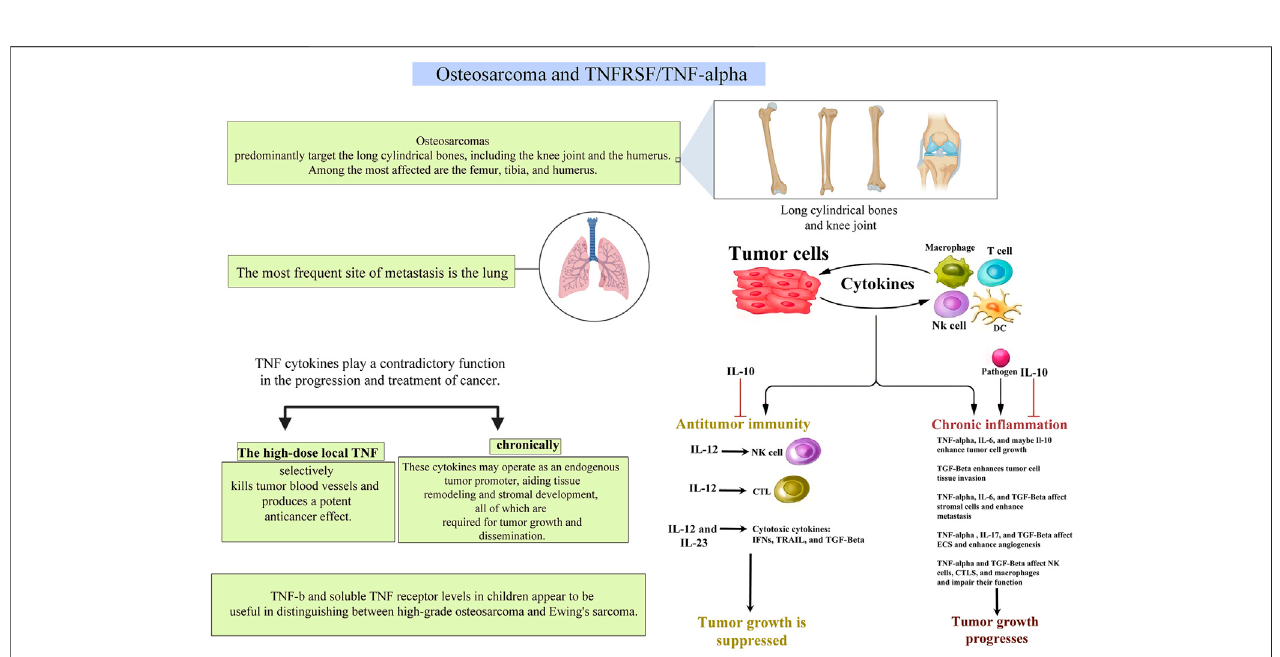
FIGURE 3 | A pictorial description of the relationship between TNFs and TNFRs and their roles in osteosarcoma.